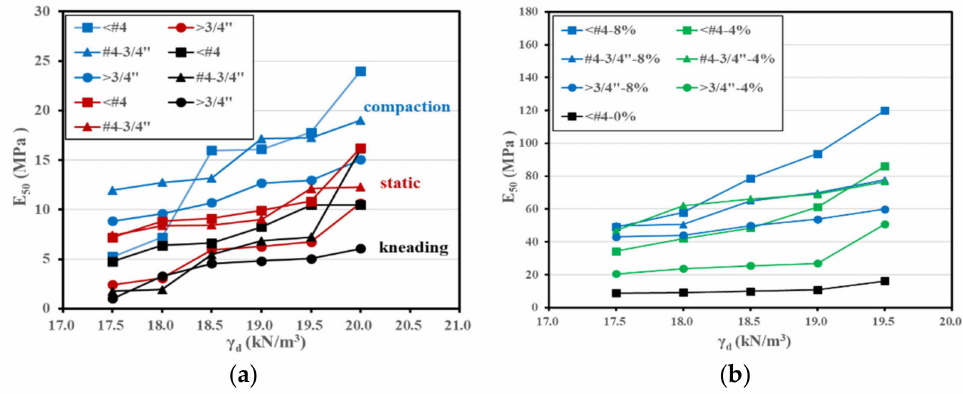
Figure 9. Elastic modulus E 50 with respect to dry density for untreated and treated samples: ( a ) mud- stone; ( b ) mudstone–cement.